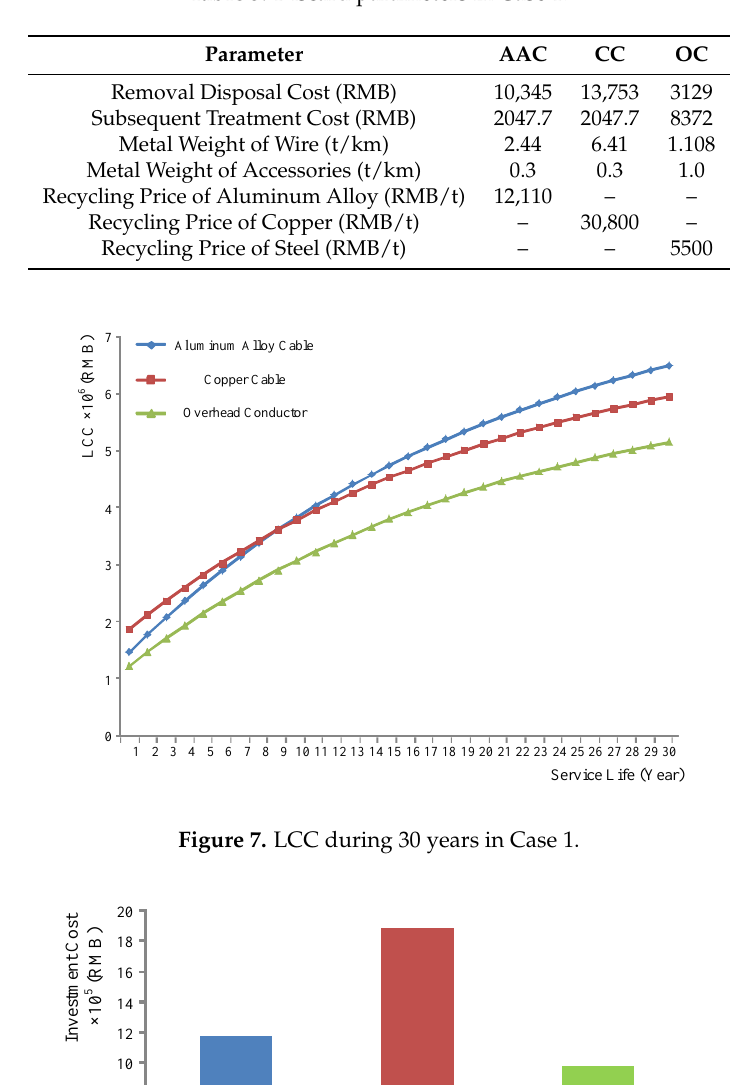
Table 5. Discard parameters in Case 1.